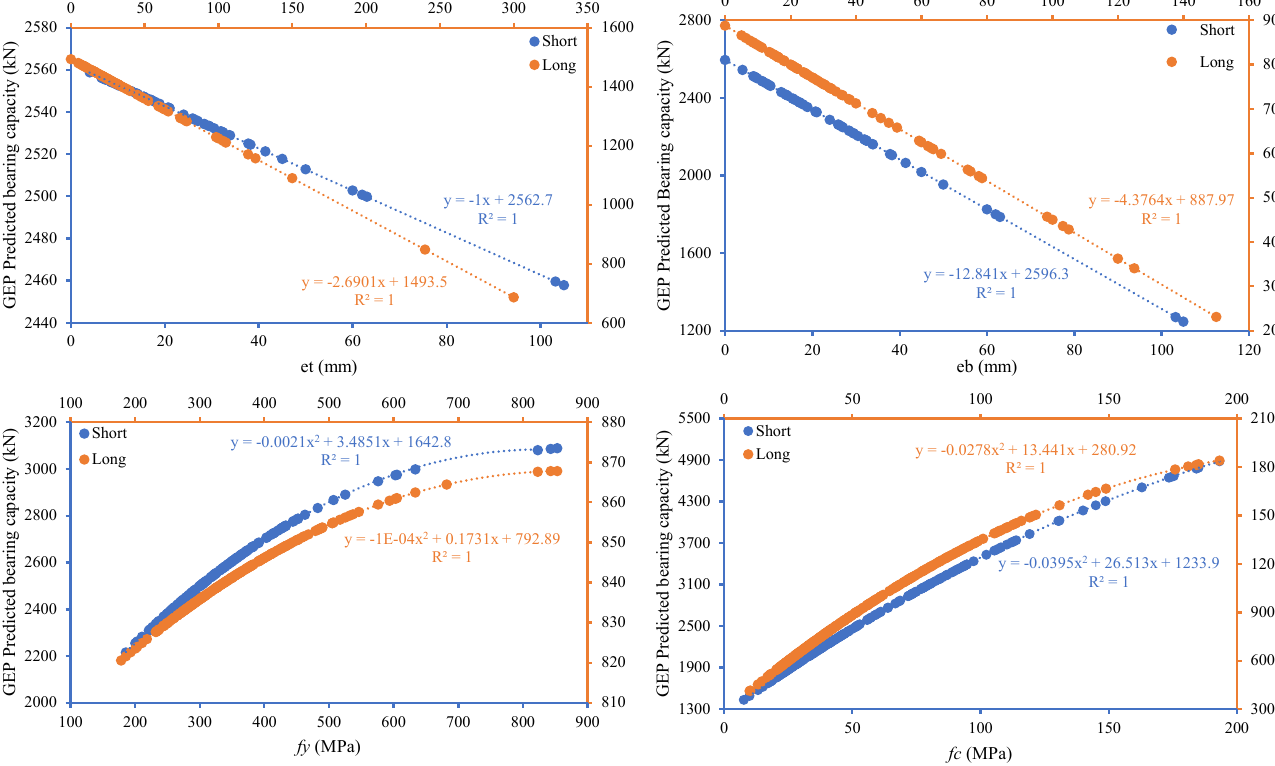
Figure 11. Summarized parametric study for formulation of bearing capacity of short and long circular CFST columns using Gene expression programming (GEP) in reference to the input variables ( D : diameter of tube, t : thickness of tube, L : length of tube, L/D : length to diameter ratio, et and eb : eccentricity at top and bottom surface, fy : yield strength of tube, fc : compressive strength of concrete).